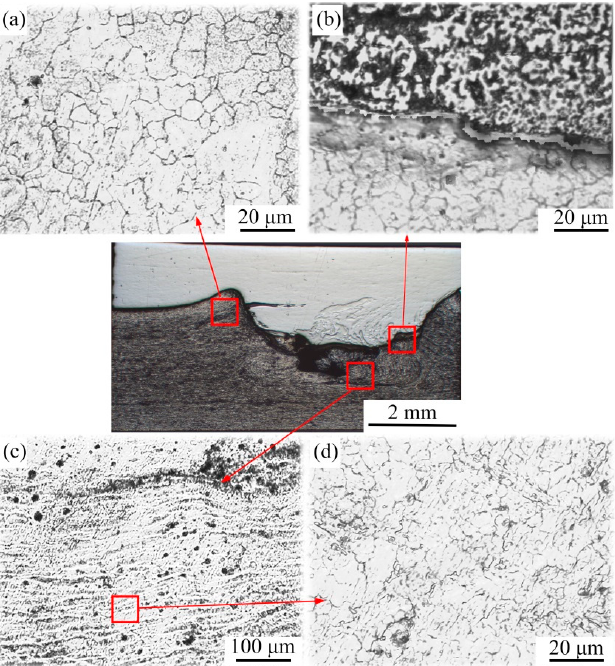
Figure 11. Transverse cross-sections of different areas ( a – d ) in the Al–Mg interface (P1).